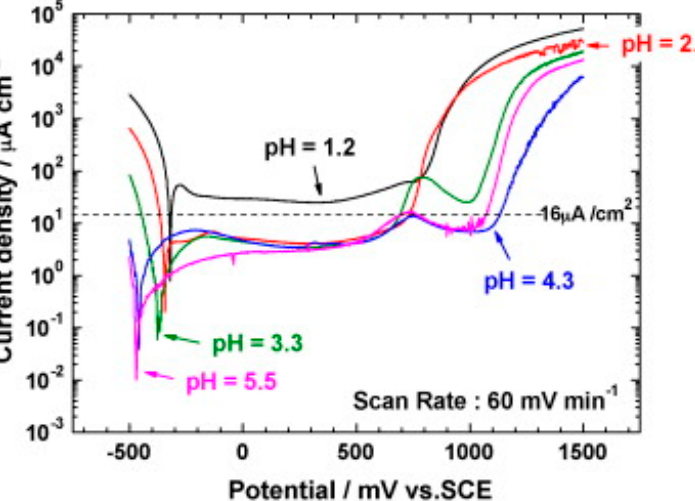
Figure 10. Effect of pH on the polarization curve of 310S stainless steel in 0.05 M H 2 SO 4 with 2 ppm F − . Reprinted from [52] copyright (2008), with permission from Elsevier.